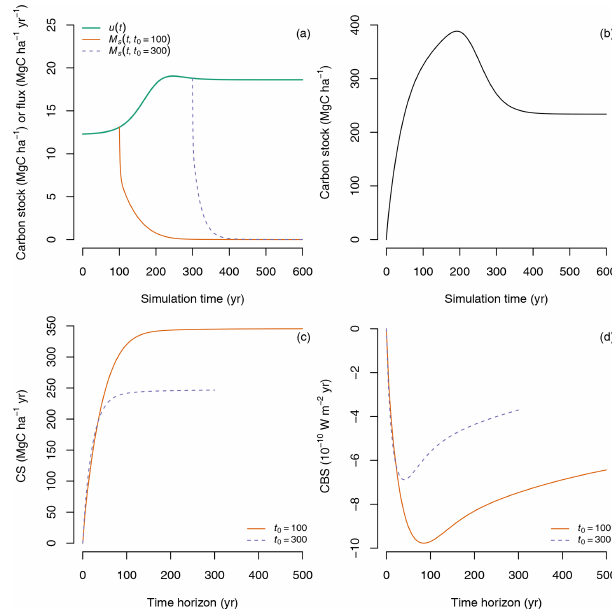
Figure 9. Prediction of CS and CBS for a non-steady-state case with time-dependent inputs u (t) controlled by CO 2 fertilization and temperature and process rates controlled by temperature modi- fied by a time-dependent factor ξ(t) . (a) Predicted time-dependent inputs u (t) , and the fate of carbon entering the ecosystem at simulation year 100 ( M s (t,t 0 = 100 ) ) and simulation year 300 ( M s (t,t 0 = 300 ) ). (b) Predicted carbon accumulation in the ecosys- tem ( (cid:107) x (t) (cid:107) ) for the entire simulation period. (c) Carbon seques- tration for the amount of inputs entering at simulation years 100 and 300 calculated for different time horizons T . (d) Climate benefit of sequestration for carbon entering the ecosystem at simulation years 100 and 300 integrated for different time horizons T